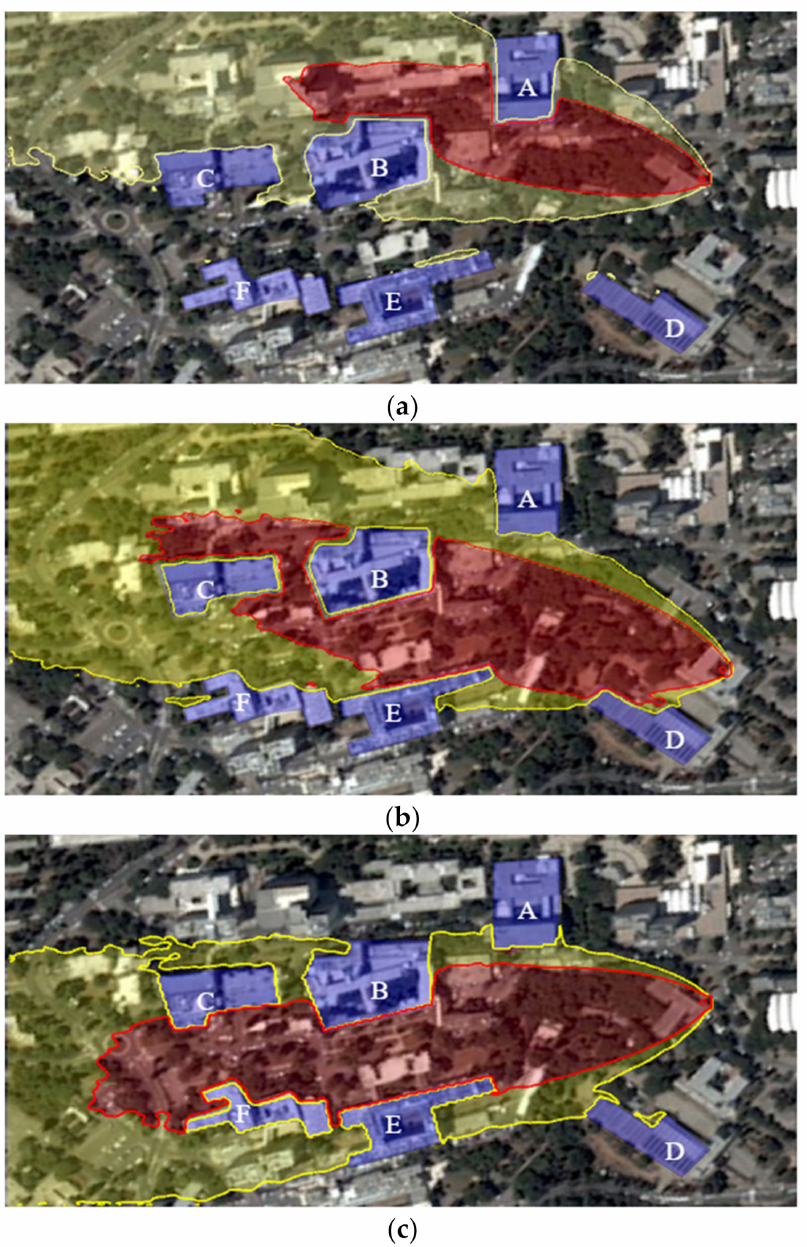
Figure 5. The three tested scenarios: ( a ) Orthogonal Passage, ( b ) Narrow Passage, and ( c ) Corridor. The six buildings inside the task zone are marked with the letters